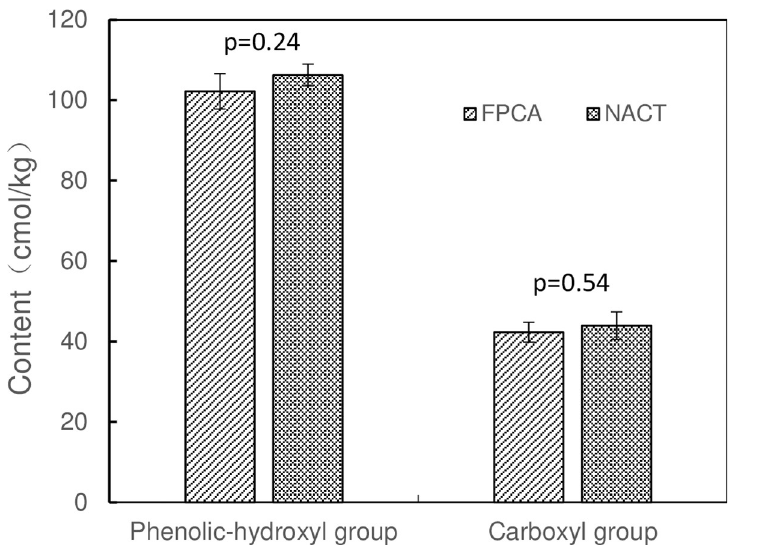
Fig 10. Comparison of NACT and FPCA methods in humic acid